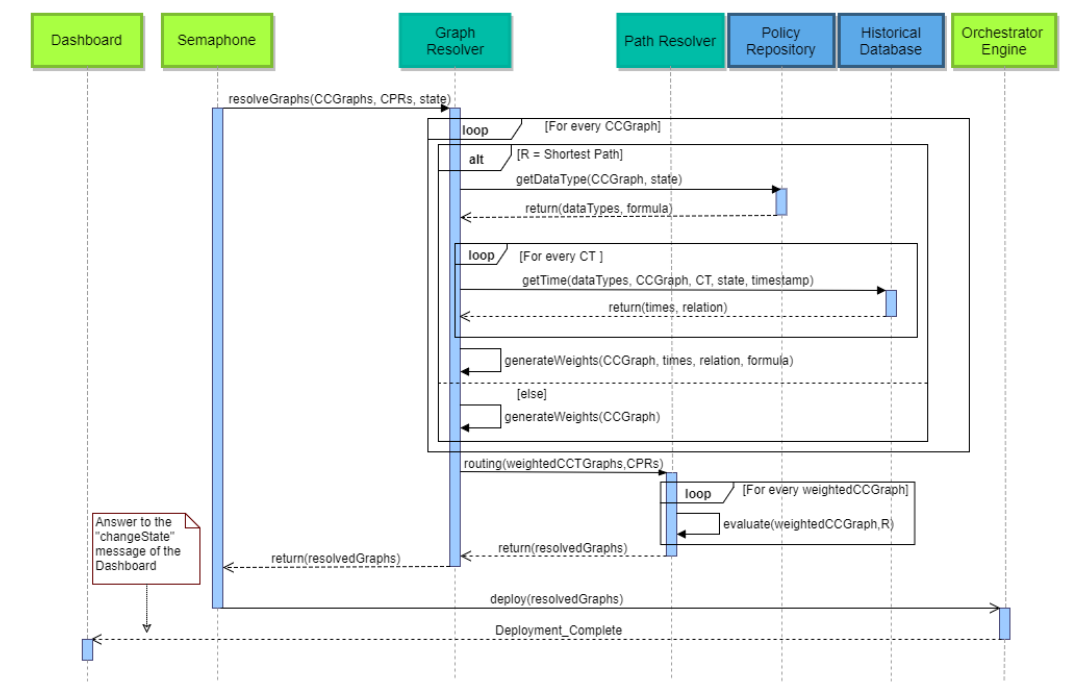
Figure 16. Graph